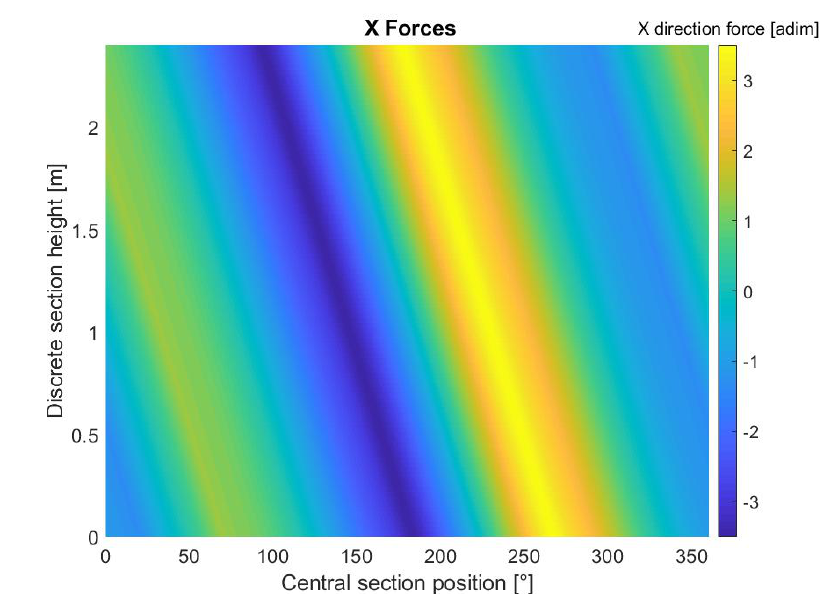
Figure 16. Distribution of x forces on discrete sections of the blade. Values are dimensionless.